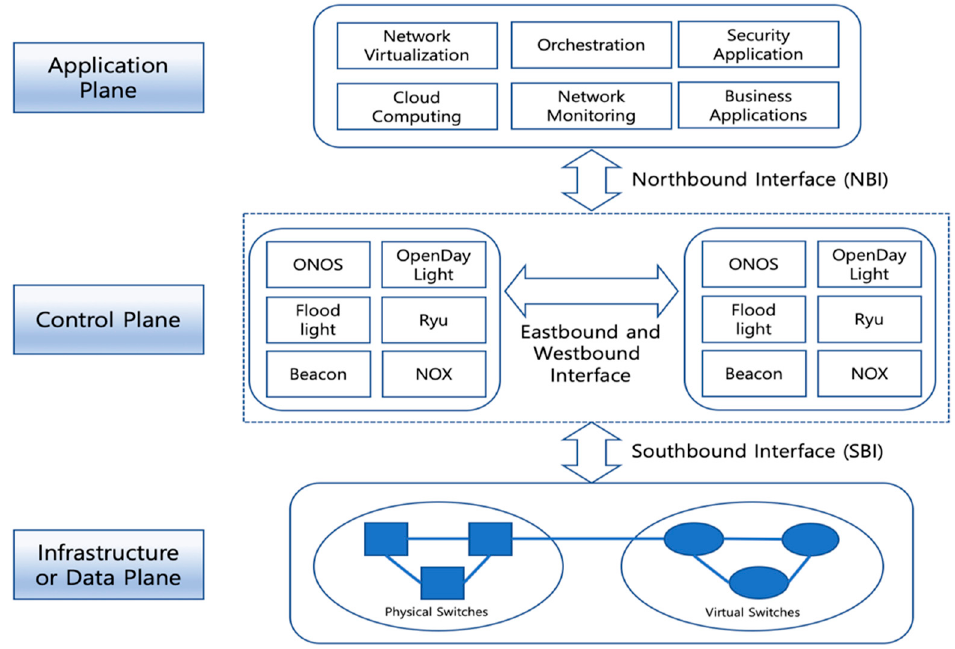
Figure 1. Fundamental software-defined network (SDN) architecture: data, control, and application planes and interfaces [23].